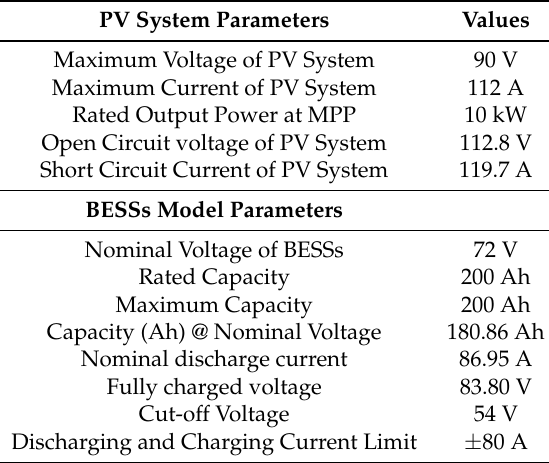
Table A2. System Parameters of Proposed DC